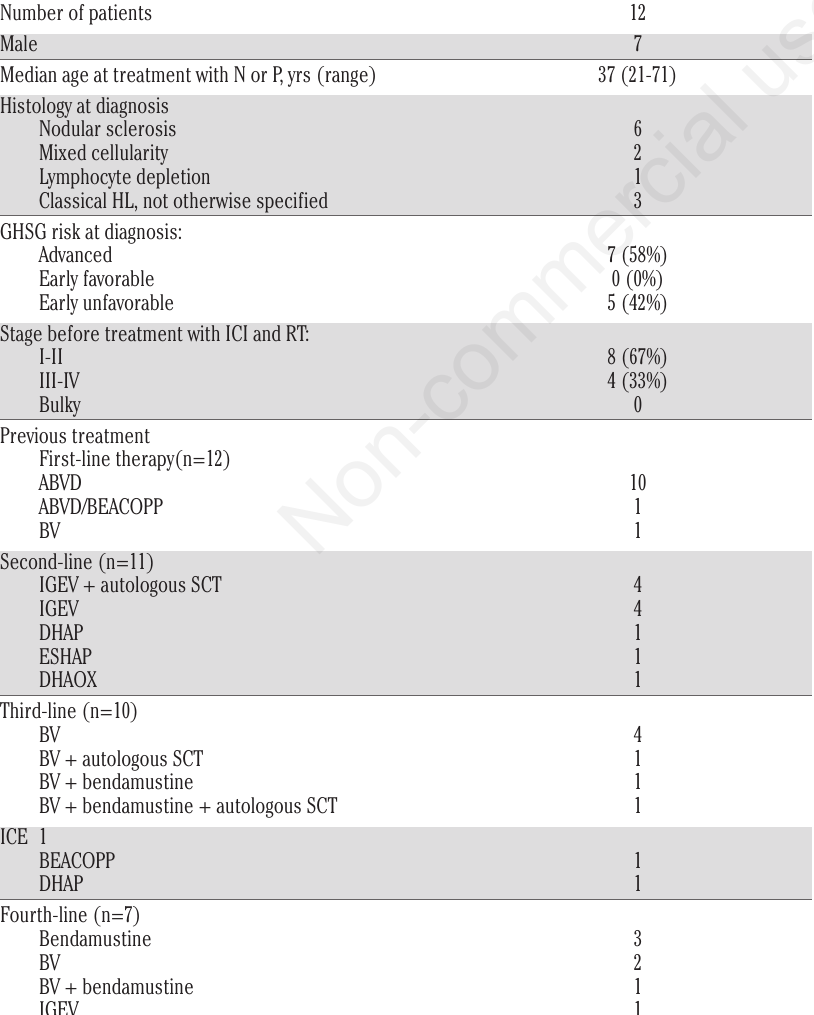
Table 1. Clinical characteristics and previous lines of treatment of 12 patients who were included in the analysis before receiving the combination of ICI and RT. Number of patients